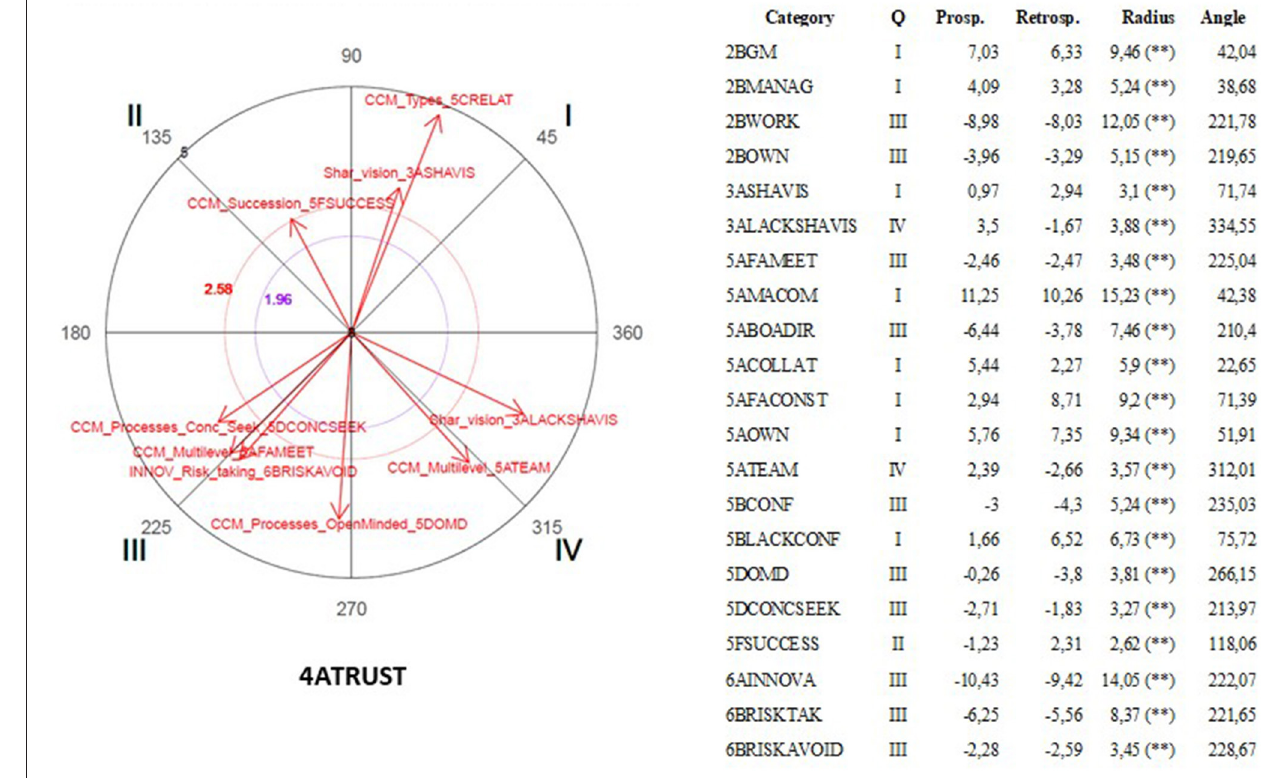
FIGURE 5 | Example B of vectorial map of the statistically significant relationships. The graph represents the vectorial map of the statistically significant relationships for the subdimension of trust (4ATRUST) considering as conditional behaviors the following: family boundaries (1A), generation (1B), family ties (1C), family history (1D), business roles (2B), shared vision (3), multilevel system (5A), perceived conflict (5B), types of conflict (5C), processes (5D), third-party assistance (5E), succession (5F), innovativeness (6A), and risk-taking orientation (6B). The table contains the results of the polar coordinate analysis. The significance level was fixed at ** p <